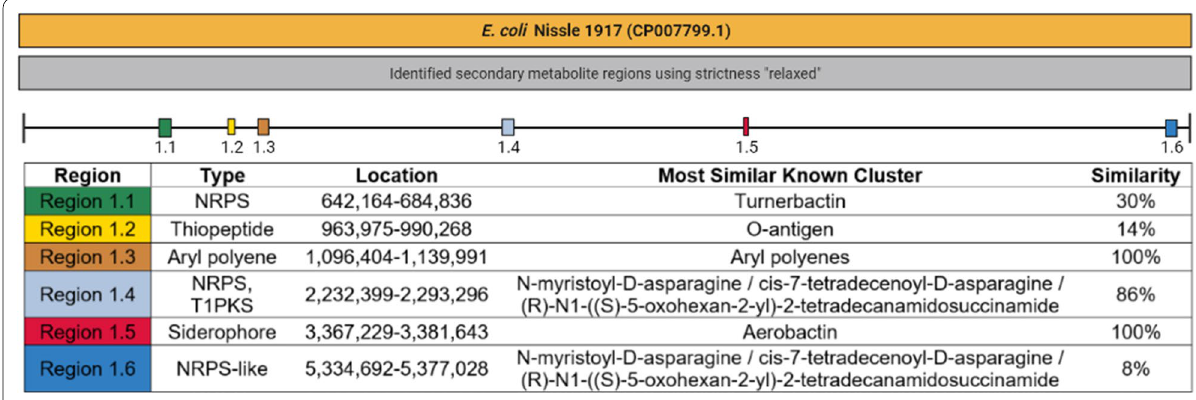
Fig. 2 Predicted secondary metabolites in E. coli Nissle 1917 (NCBI Accession number: CP007799.1) and similar gen clusters with